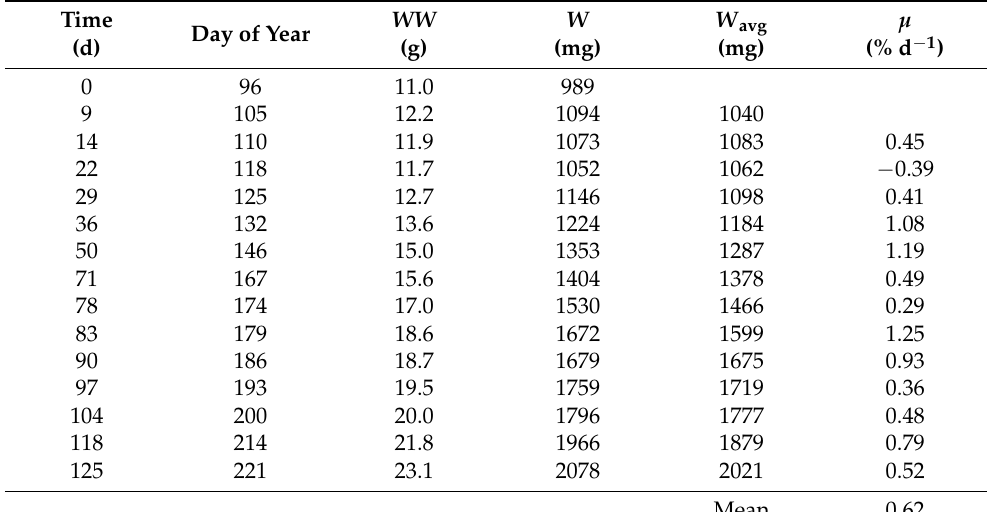
Table A1. Halichondria panicea . Development of sponge wet weight ( WW ), dry weight ( W ), average dry weight ( W avg ) in time interval and weight-specific growth rate ( µ ) as a function of time (d) in growth experiment with sponge explants in the inlet to Kerteminde Fjord, Denmark. Data used for calculation of µ are from [6].